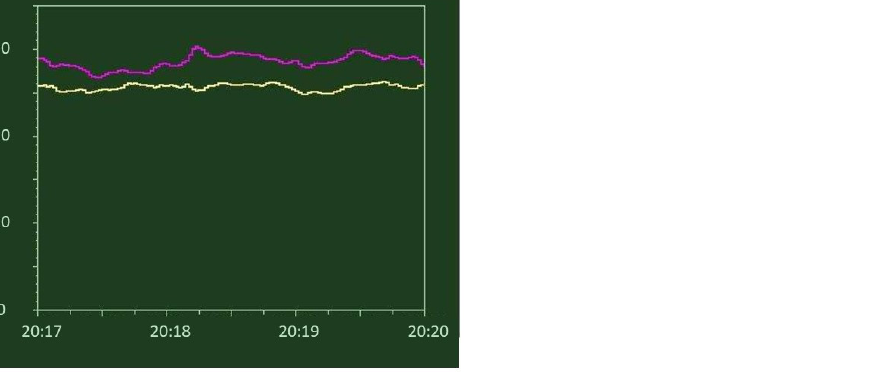
Figure 3. Online measurement of FEL intensities in two-color mode with two gas monitor detectors. Pulse energies in microjoules are shown for 7 nm (yellow) and for 10 nm (pink) versus real time.The figure was published in [17].